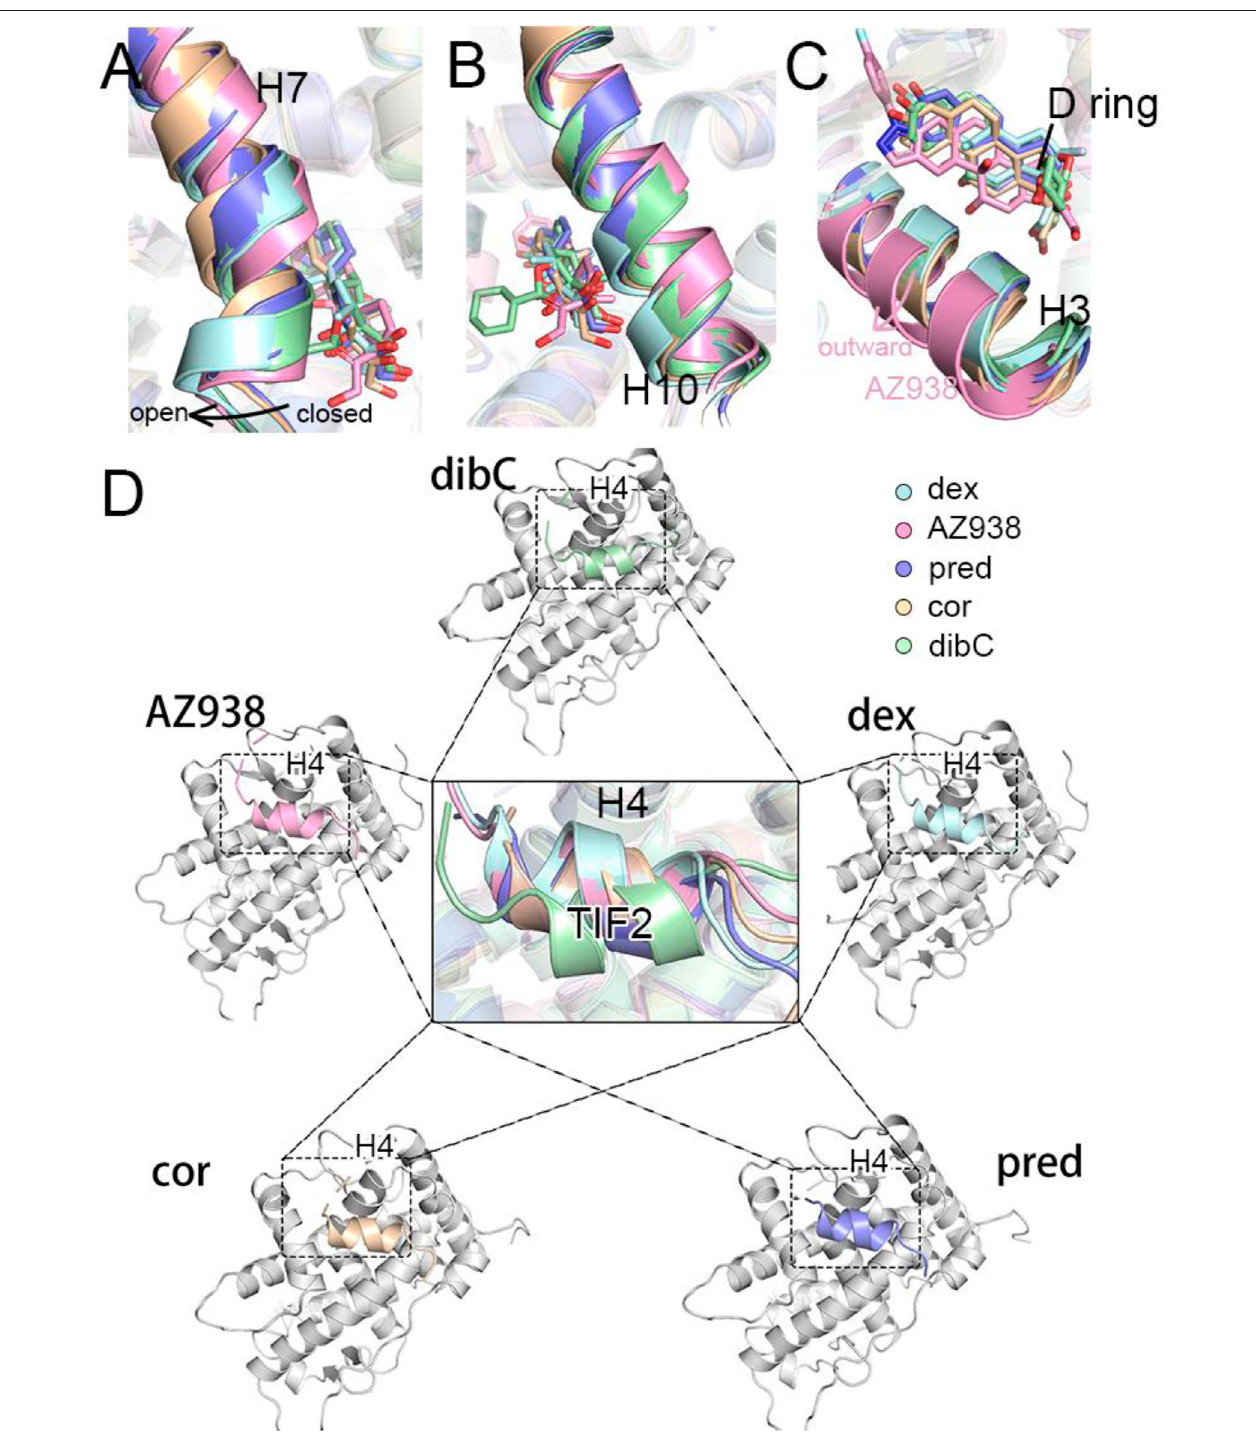
FIGURE 2 | Representative structures of fi ve systems. (A) cartoon representations of H7 and ligands. (B) cartoon representations of H10 and ligands. (C) cartoon representations of H3 and ligands. (D) cartoon representations of TIF2 in the cofactor pocket.